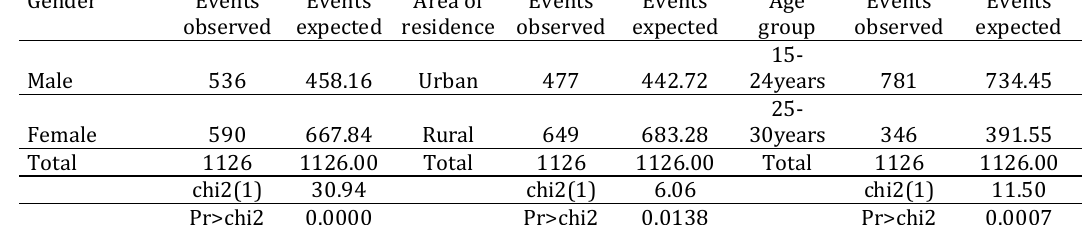
Table A2: Log-rank test for equality of survivor functions